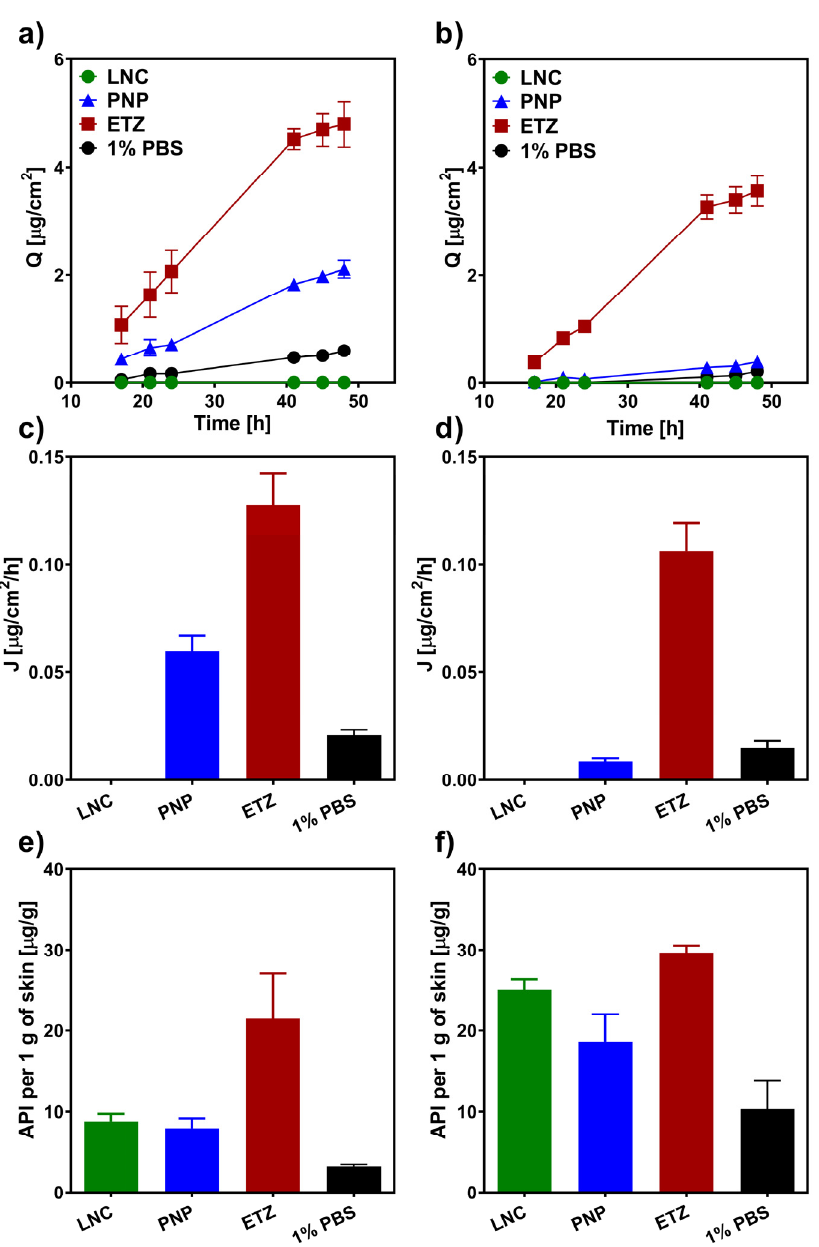
Figure 5. Permeation characteristics of hydrocortisone-17-butyrate (HCB) from the ex vivo perme- ation study. The left column (graph ( a , c , e )) represents the results obtained on porcine skin, the right column (graph ( b , d , f )) contains results from the human skin. The first row (graph ( a , b )) depicts permeation profiles as the dependency of cumulative amount on time. The second row (graphs ( c , d )) contains flux values of HCB liberated from various nanoformulations. The bottom row (graph ( e , f )) shows the entrapment of in the skin presented as the amount of HCB per 1 g of the skin. n ≥ 12.